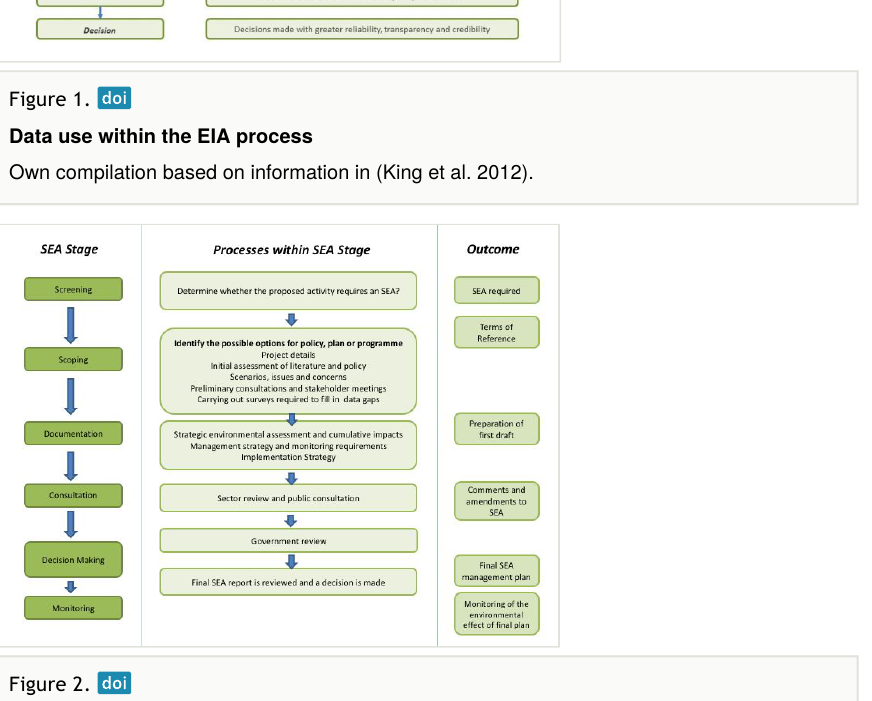
Figure 2. Steps in the Strategic Environmental Assessment